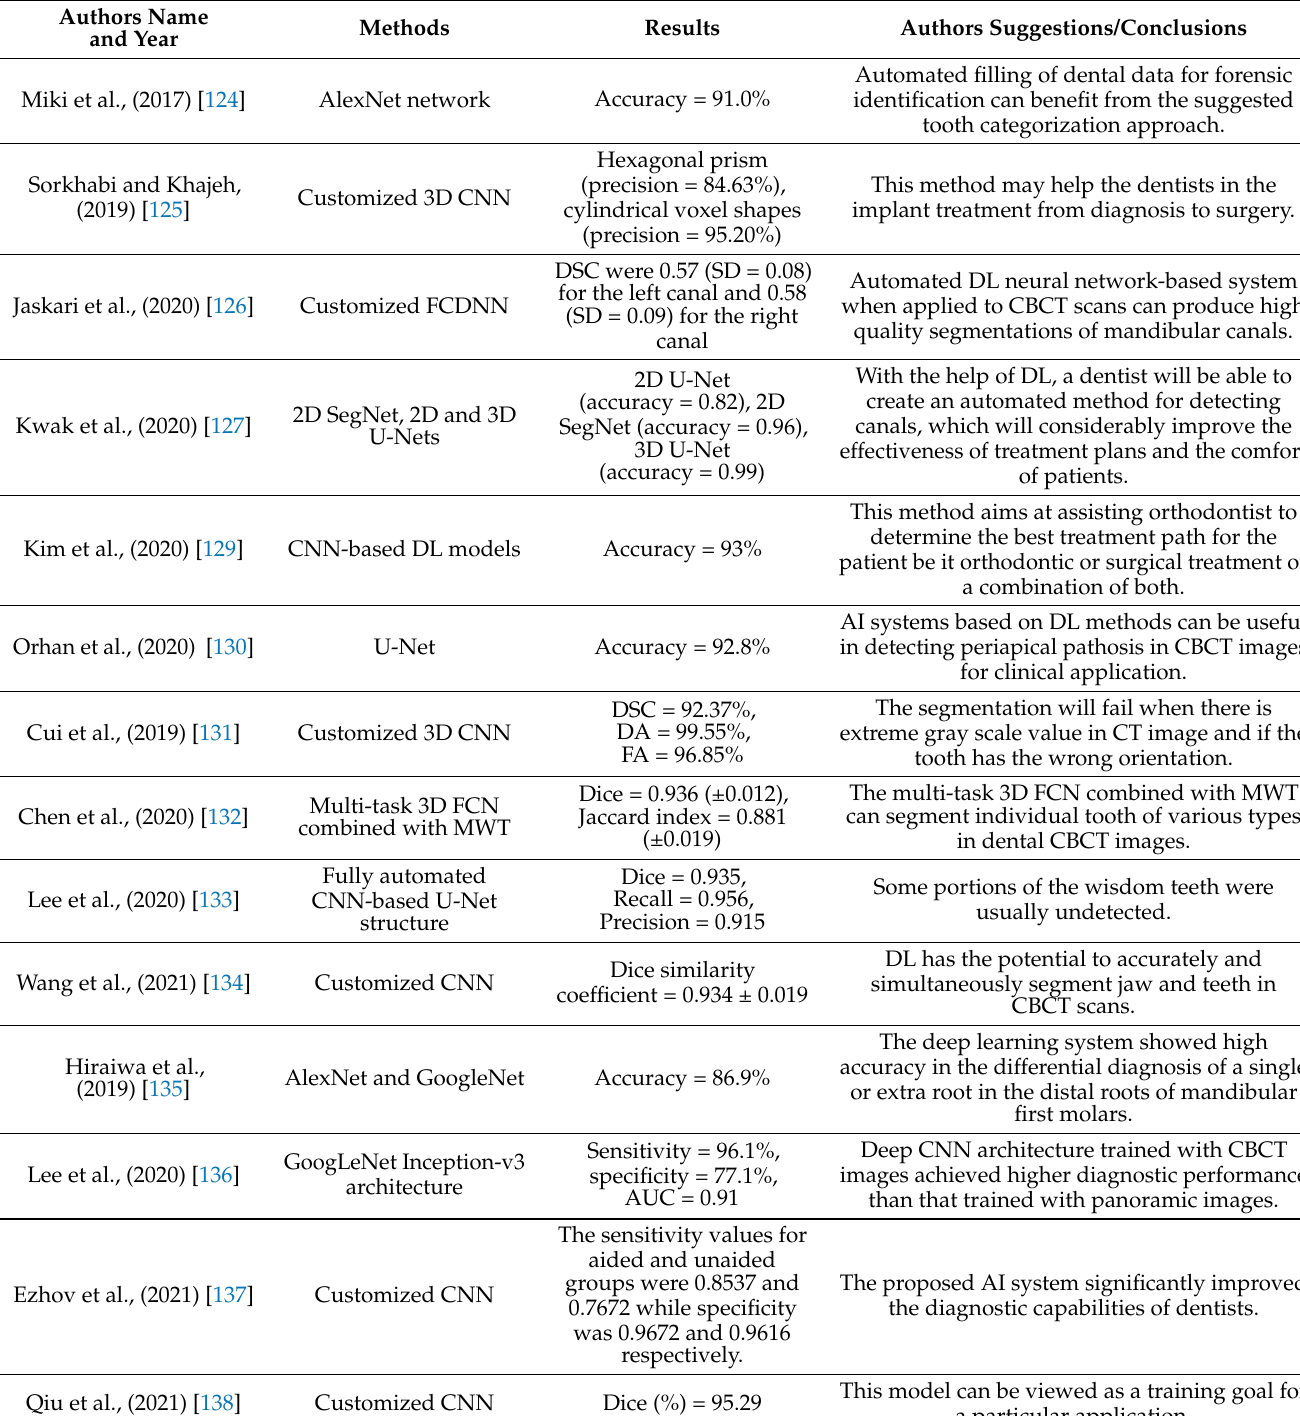
Table 10. CBCT selected